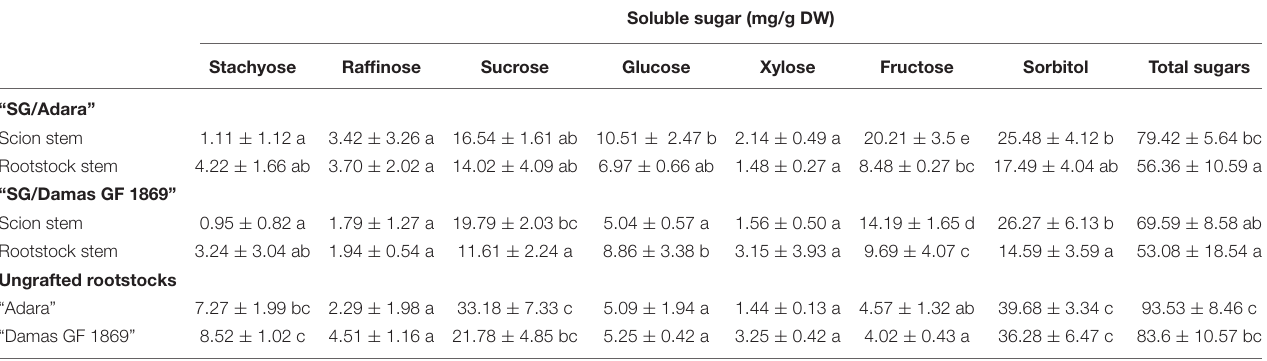
TABLE 2B | Stem soluble sugars (mg/g DW) in the bark from the scion and rootstock of the compatible (“SG/Adara”) and incompatible (“SG/Damas GF 1869”) graft-combinations, and ungrafted rootstocks at the vegetative period. Soluble sugar (mg/g DW)